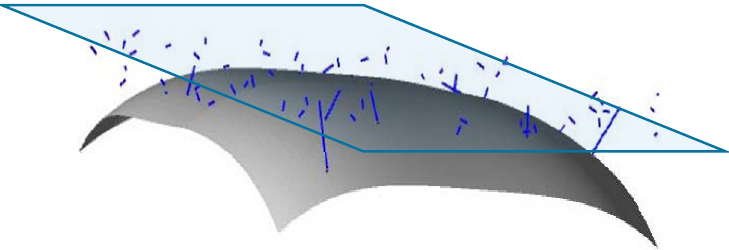
Figure 7. Geometrical relation between the curved PV panel (curved detector, opaque gray surface) and light source (corresponding to the projected area, semi-transparent light-blue area). The line segment around the light source (semi-transparent light-blue area) corresponds to the rays emitted from the light source. The short line segments correspond to the ray that does not reach the curved surface. The longer line segments correspond to the one that hits the curved PV panel (curved opaque gray surface), namely the ray that is absorbed by the PV. Note that rays just above the module do not always hit the module due to its curvature [1].